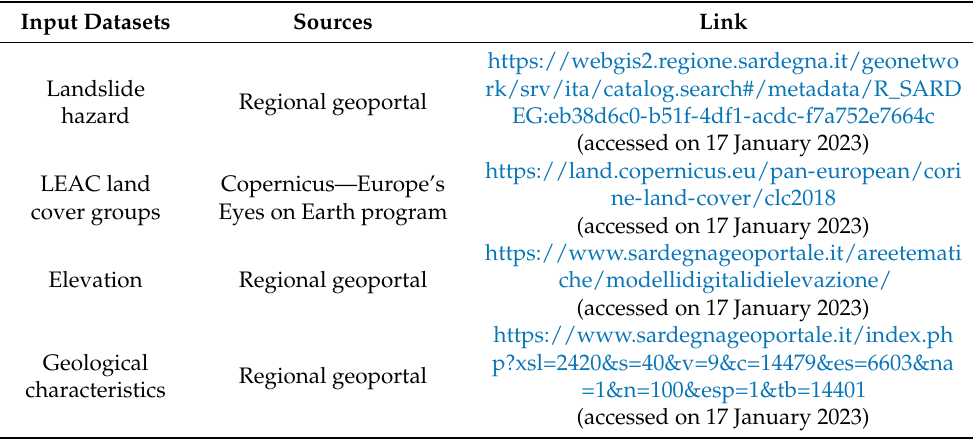
Table 1. Input datasets used to compute dependent and explanatory